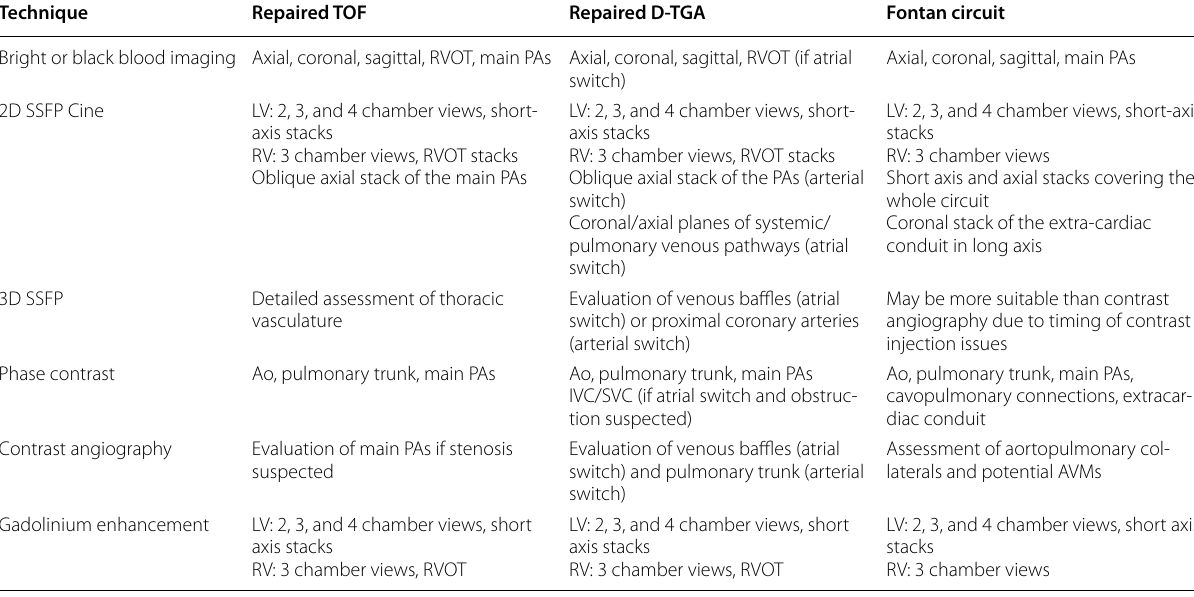
Other techniques such as further tissue characterisation by T2-weighted imaging and myocardial mapping can also be considered, if there are relevant indications Ao, aorta; AVM, arteriovenous malformation; IVC, inferior vena cava; LV, left ventricle; PA, pulmonary artery; RVOT, right ventricular outflow tract; RV, right ventricle; SVC, superior vena cava